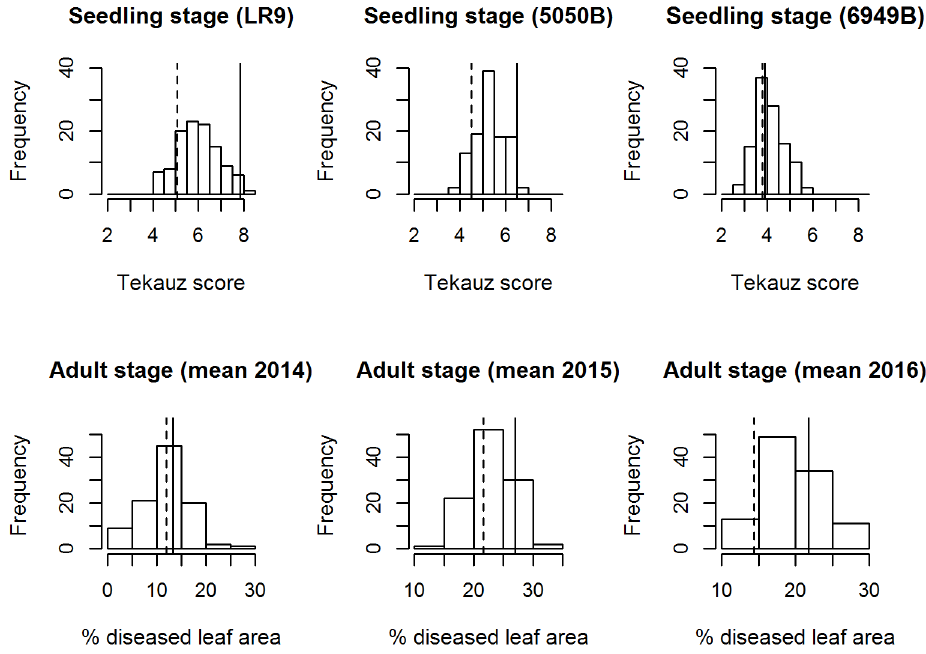
Fig 1. Frequency distributions for disease severitiesin the Arve x Lavrans mapping population. Diseaseresponsesare shown as Tekauz scores in seedlinginoculations with three different isolates LR9. 5050B and 6949B and as percentage of diseasedleaf area for adult plants under inoculated field conditions in three years. Vertical solid line represents the diseasescores of Arve, vertical dashedlines representsdisease scores of